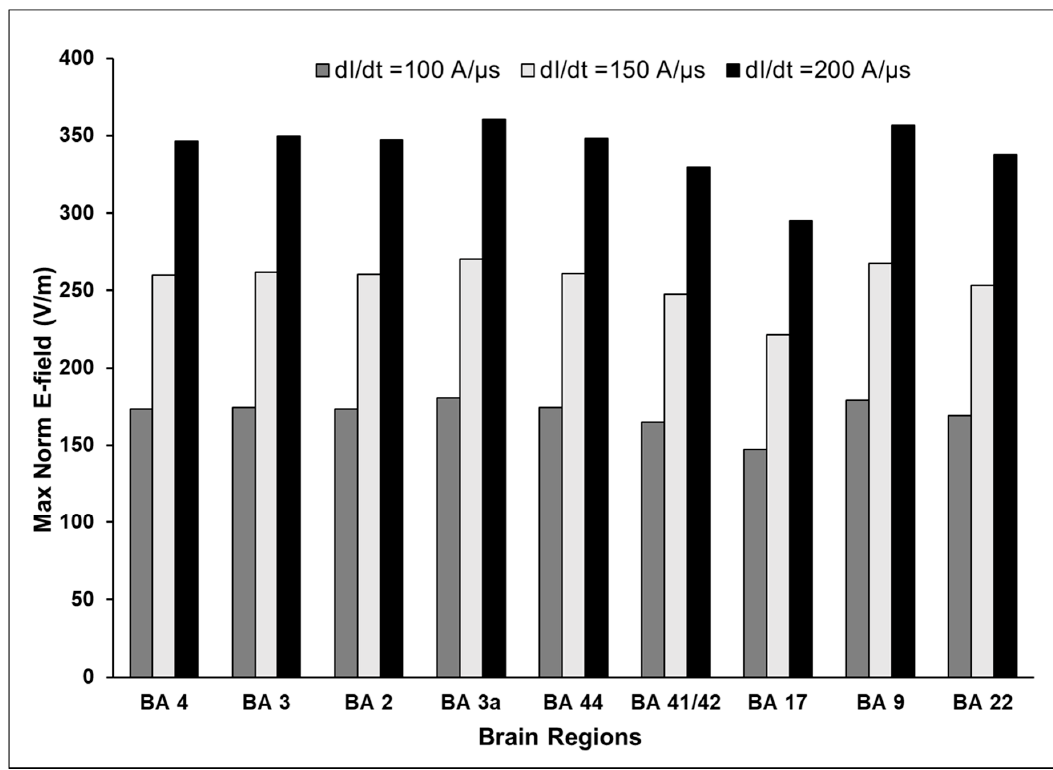
Figure 5. Across all brain areas examined, the induced E-field on the cortical surface increased by 33% when dI/dt increased by 50 A/µs. We verified that this holds true for the different coil orientations considered in this study. The volume of cortex exposed to ≥ 75% maximum E-field remained unchanged across the three intensities.